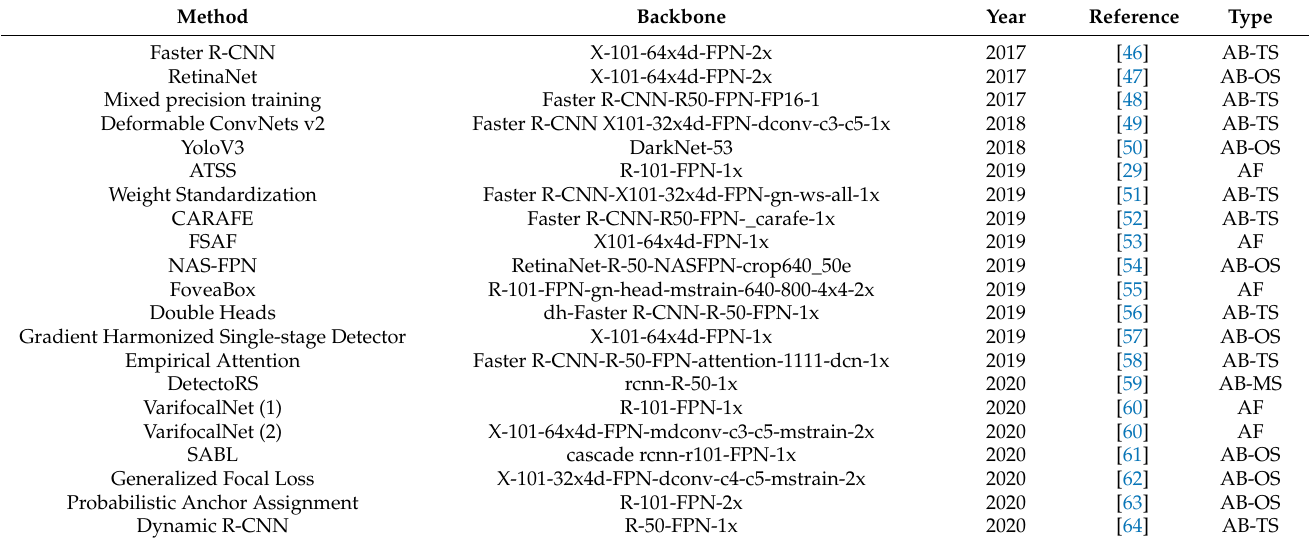
Table 2. The object detection methods used in this study, including backbone, year of publication, reference, and type of method.